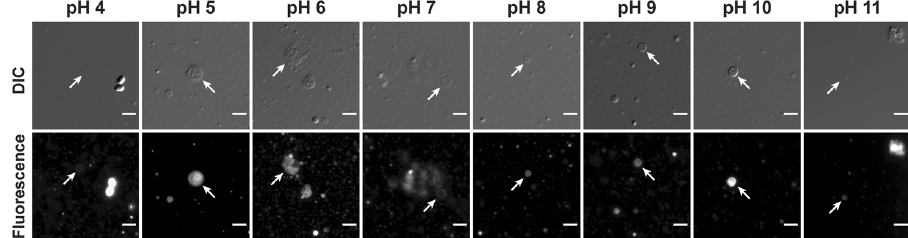
Fig. 2 Vesicle formation behavior of the NOG + GMO mixed system. A mixture of NOG and GMO (6 mM total amphiphile; 2:1 ratio) generates vesicles from pH 4 to 11, as observed under differential interference contrast (DIC) and fl uorescence microscopy. Vesicles are indicated by white arrows. For fl uorescence-based imaging, vesicles were stained with 10 μ M of an amphiphilic dye named Octadecyl Rhodamine B Chloride (R18). The scale bar is 10 µ m.